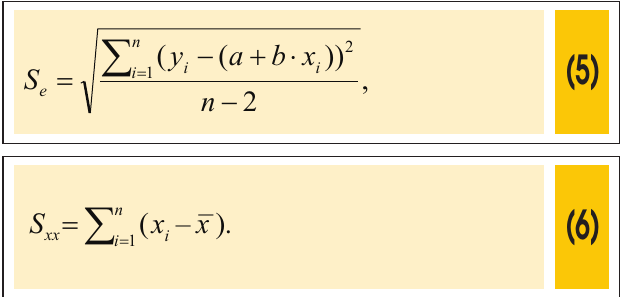
where x and y correspond, respectively, to the dependent and in - dependent variables; a and b correspond, respectively, to the lin - ear coefficient and the slope; E is the predicted error for the p–individual individual values and E is the predicted error for the mean p–medio values; S corresponds to the standard error of the estimate and e is calculated using equation (5), n refers to the sample size, i.e., the number of points used to define the correlation curve; x corre - sponds to the average value of the variable x; and S is the sum of xx the residues of the variable x given by equation (6).